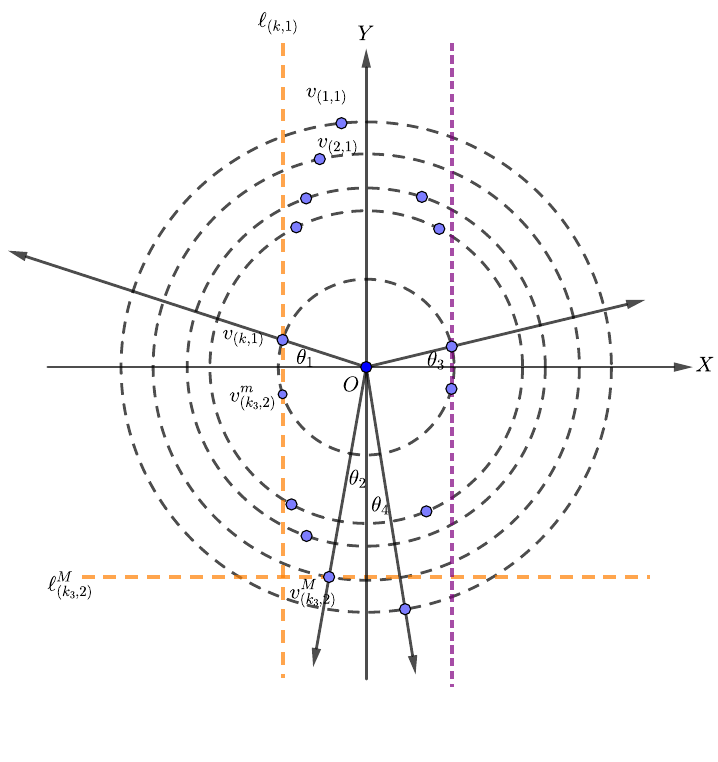
Figure 4. The perturbation of the points to find the strictly convex configuration when max { m 1 , . . . , m k } =